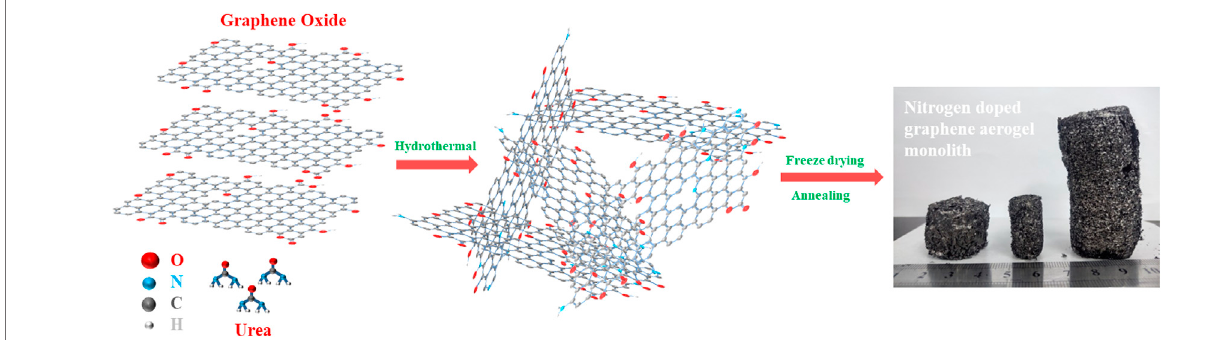
SCHEME 1 | Schematic illustration of the fabrication process for the NG monolith